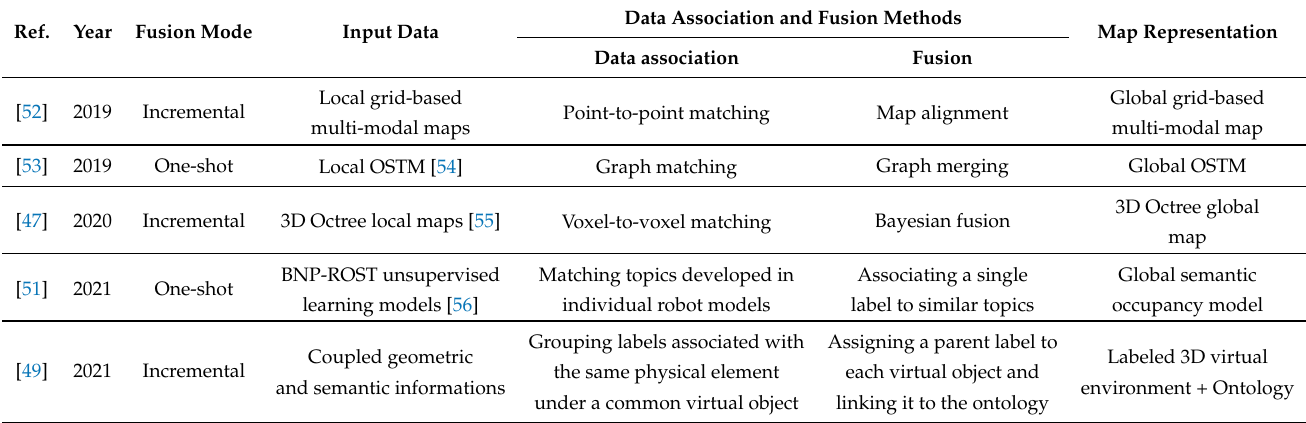
Table 2. Different data association and fusion techniques used in collaborative semantic